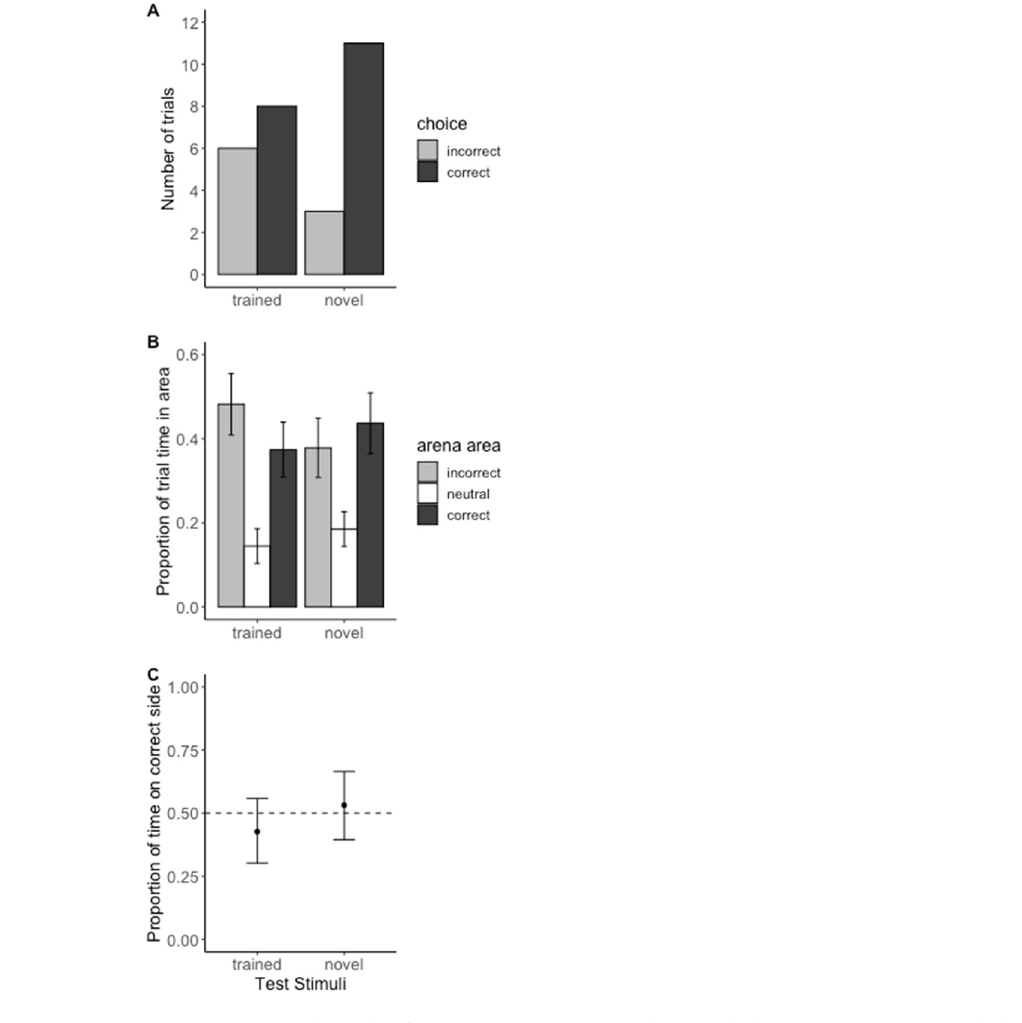
Figure 4. Test trial results from Experiment 1—within modality ‘sameness’ assay . ( A ) Barplot of initial choice in two-choice tests. The initial choice for trained stimuli tests (X-squared = 0.28571, df = 1, p -value = 0.593) and the initial choice for novel stimuli tests (X-squared = 4.5714, df = 1, p -value = 0.03251) were not statistically different. ( B ) Average proportion of time spent in each area of the arena during test trials with standard error bars. ( C ) Modeled estimates and their 95% confidence intervals of the proportion of time spent in front of C+ door (excludes neutral zone). A value of 0.5 represents an equal amount of time spent in front of both doors. Phrynus marginemaculatus did not spend significantly more time in front of the C+ door, suggesting they did not learn the concept of ‘same’.